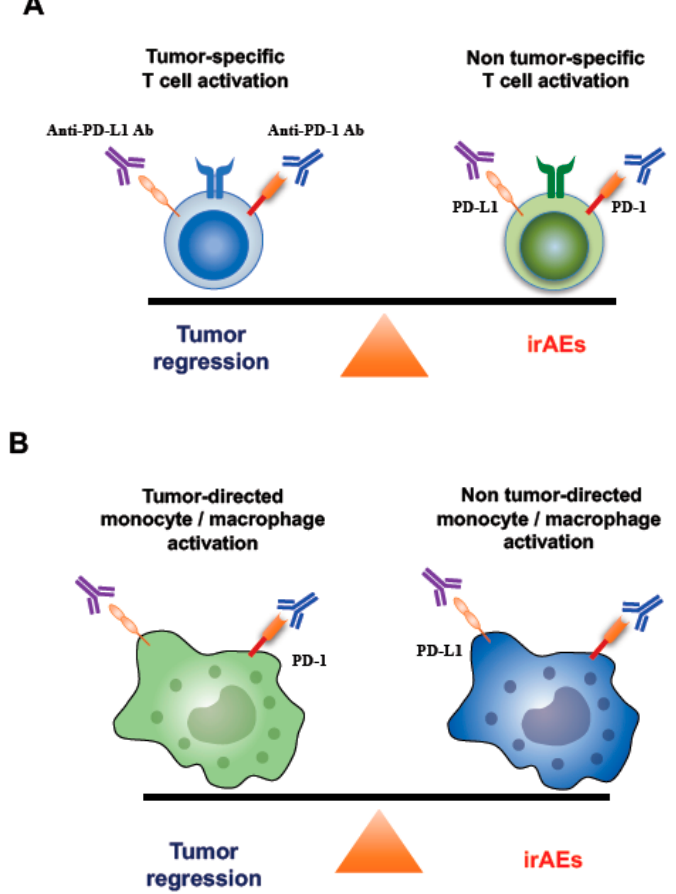
Figure 7. Underlying mechanisms of irAEs caused by activated T cells and monocytes / macrophages. ( A ) A model of immune balance between tumor-specific and non-tumor-specific T cells. ICIs can activate not only tumor-specific T cells but also non-tumor-specific T cells. Thus, ICIs have the potential to modulate the balance between tumor-specific T cell response and non-tumor-specific T cell response. PD-1 / PD-L1 express on both tumor-specific and non-tumor-specific T cells. If non tumor-specific T cells are dominantly activated by ICIs, this may lead to the onset of irAEs. ( B ) A model of immune balance between tumor-directed monocyte / macrophage activation and non-tumor-directed monocyte / macrophage activation. PD-1 / PD-L1 express on both tumor-directed and non-tumor-directed monocytes / macrophages. Thus, ICIs could activate both tumor-directed and non-tumor-directed monocytes / macrophages and have the potential to modulate the immune balance. If non tumor-directed monocytes / macrophages are dominantly activated by ICIs, this may lead to the onset of irAEs such as disorders of the coagulation-fibrinolysis